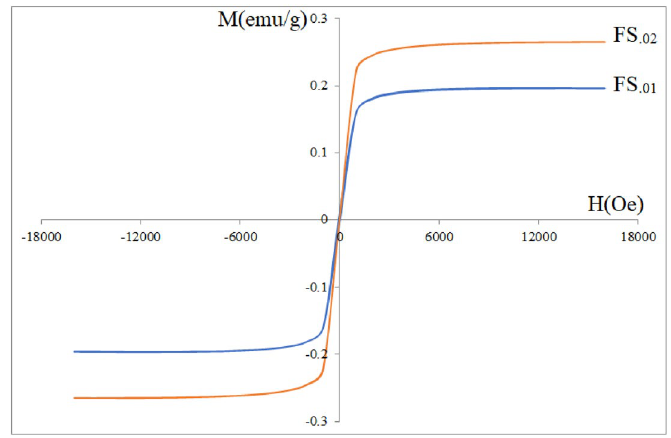
Figure 11. Room temperature M-H curves of the FS .01 and FS .02 in an aqueous medium.